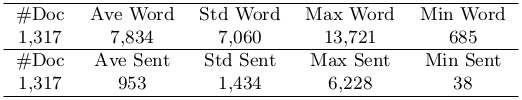
Table from the paper: IcoRating: A Deep-Learning System for Scam ICO Identification
Table text:
#Doc
AveWord
StdWord
MaxWord
MinWord
1,317
7,834
7,060
13,721
685
#Doc
AveSent
StdSent
MaxSent
MinSent
1,317
953
1,434
6,228
38